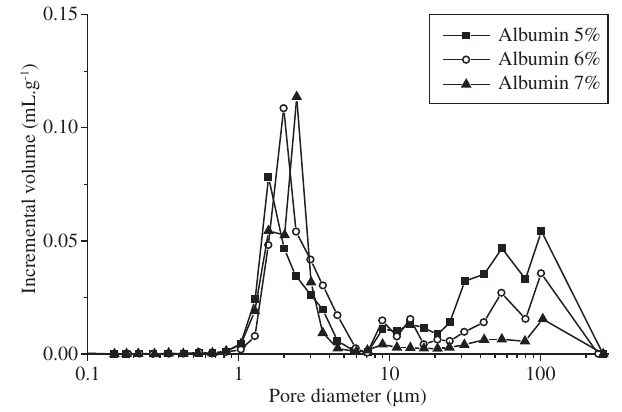
Figure 5. Curves of pore size distribution frequency as a function of volume intruded